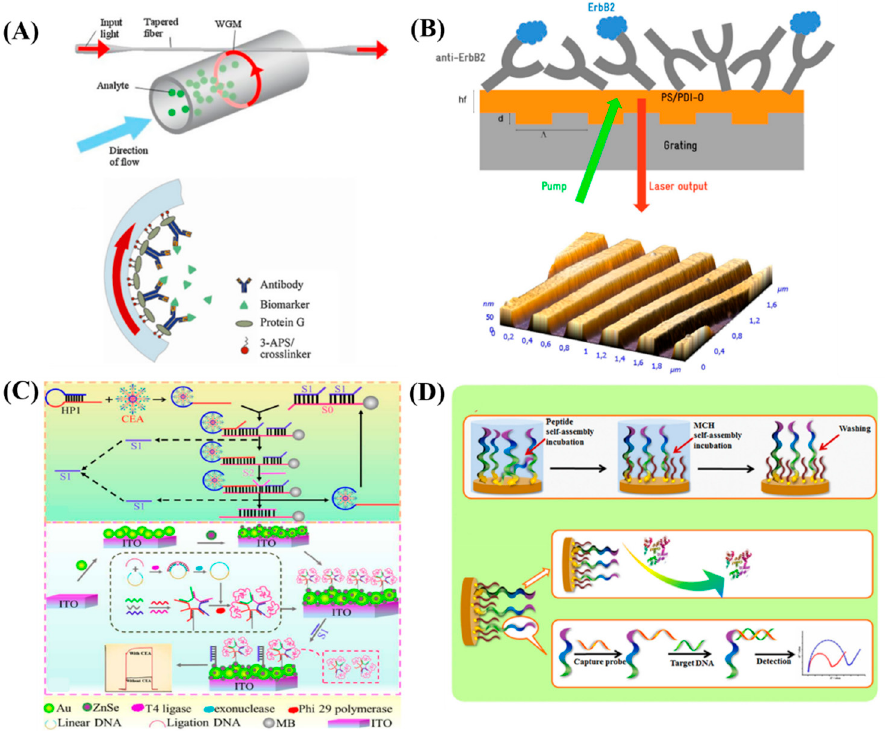
Figure 3. ( A ) Schematic representation of the OFRR sensor. Re-used with permission from Ref. [25] (Copyright, 2010 Elsevier, reproduced with permission from Elsevier Ltd.). ( B ) Scheme of the DFB laser sensor. Re-used with permission from Ref. [26]. (Copyright, 2016 Elsevier, reproduced with permission from Elsevier Ltd.) ( C ) Schematic of the PEC biosensor for CEA determination. Re-used with permission from Ref. [27]. (Copyright, 2016 Elsevier, reproduced with permission from Else- vier Ltd.) and ( D ) Schematic illustration of Peptide SAM formation, fabrication and sensing proce-